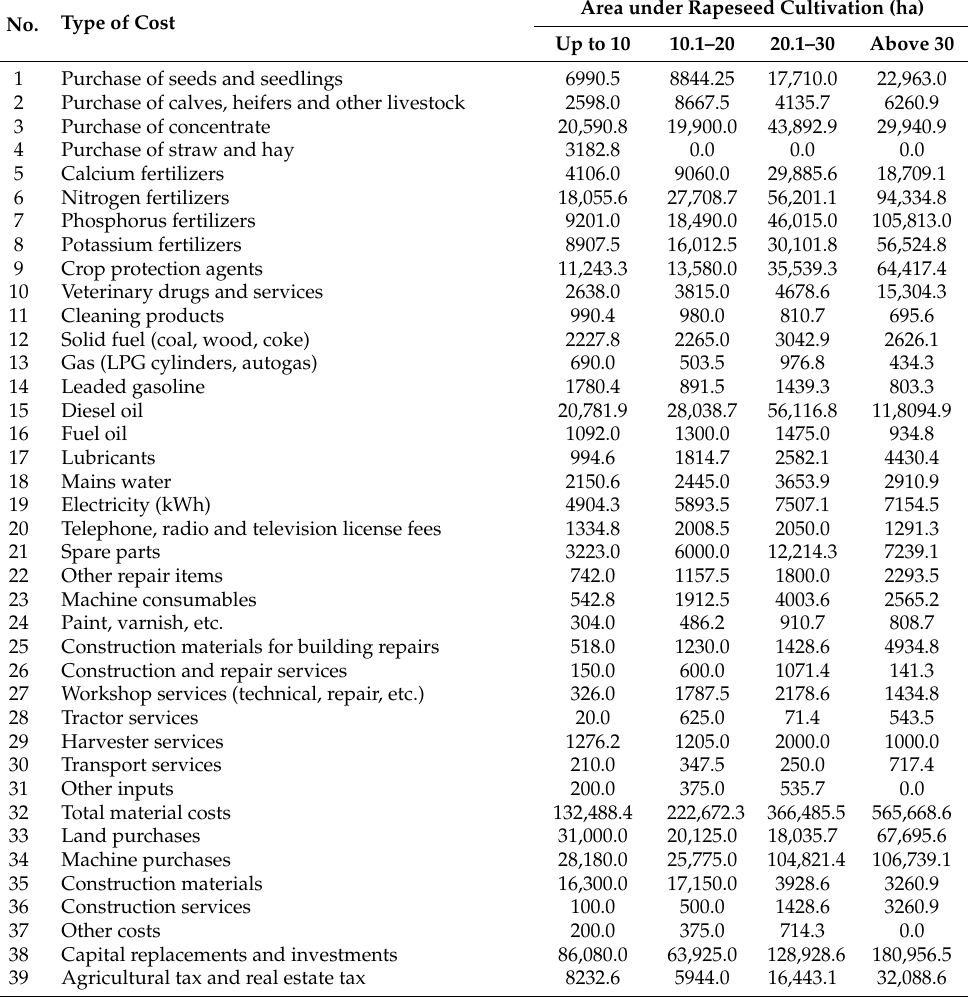
Table 6. Total annual costs in the analyzed farms